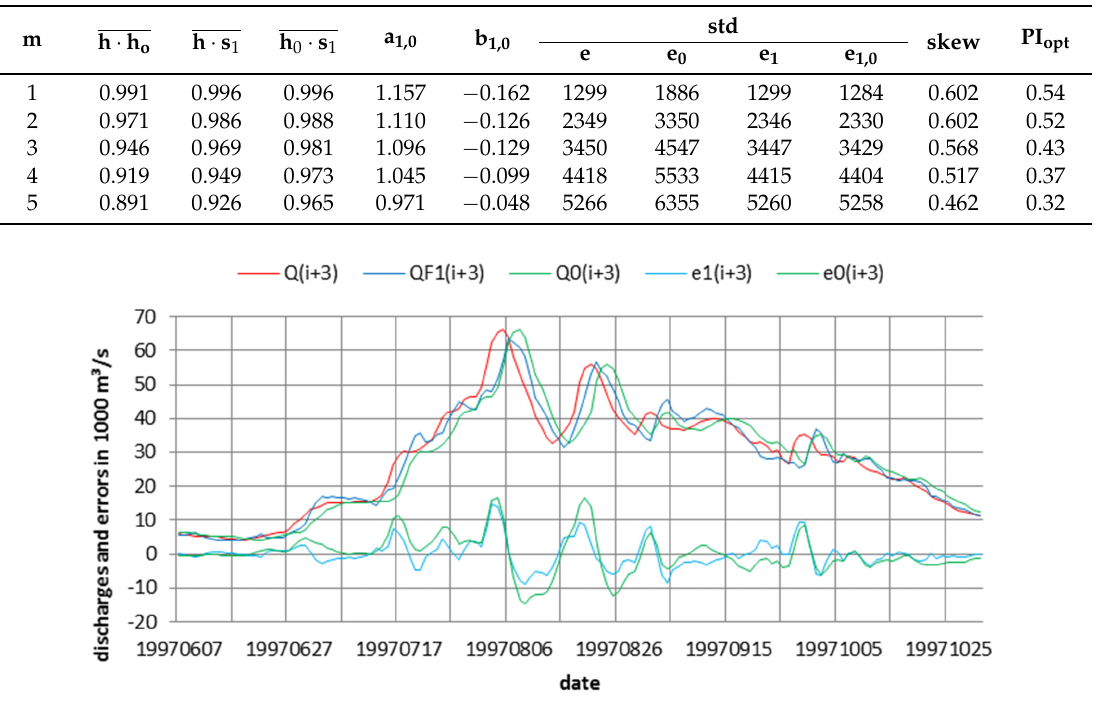
Figure 2. Forecast results for m = 3 days with model 0 and model 1 for Stung Treng in 1997.